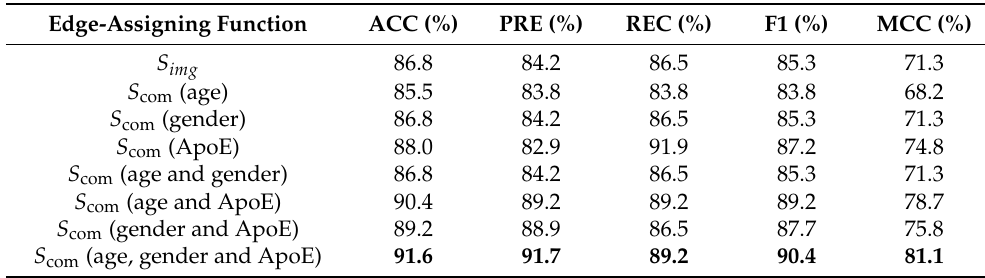
Table 2. GCN model performance under AD versus CN task on the test data with different edge- assigning functions. The best results are given in bold.